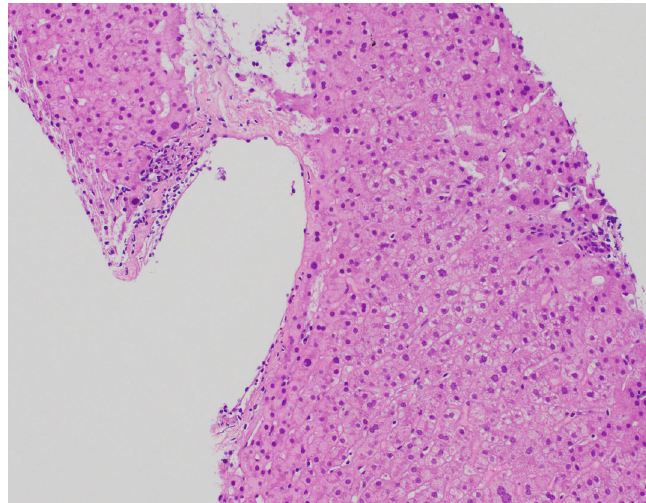
Figure 1: The liver biopsy shows venous endotheliitis which is one of the diagnostic features of acute cellular rejection (hematoxylin and eosin stain, original magni fi cation ×